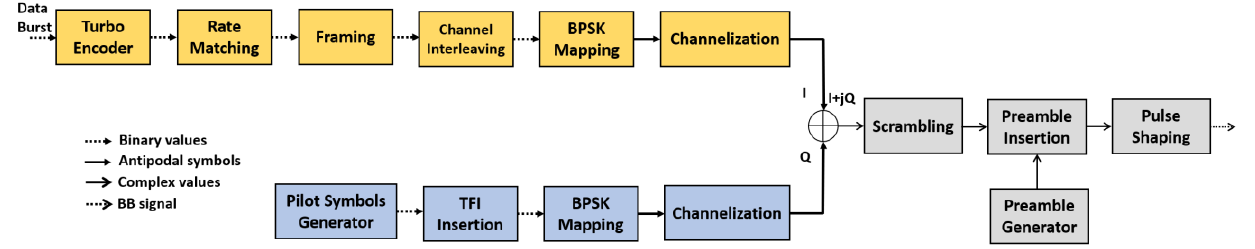
Figure 2. F-SIM transmitter functional block diagram.